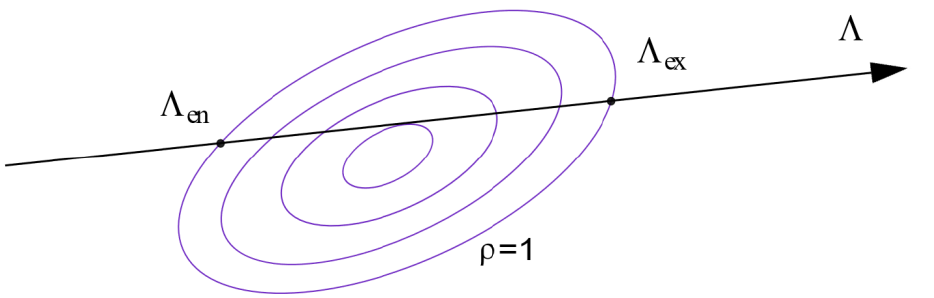
Figure 1. Neutral particle injection line crossing an arbitrary system of convex closed curves representing a cross-section of nested magnetic surfaces.